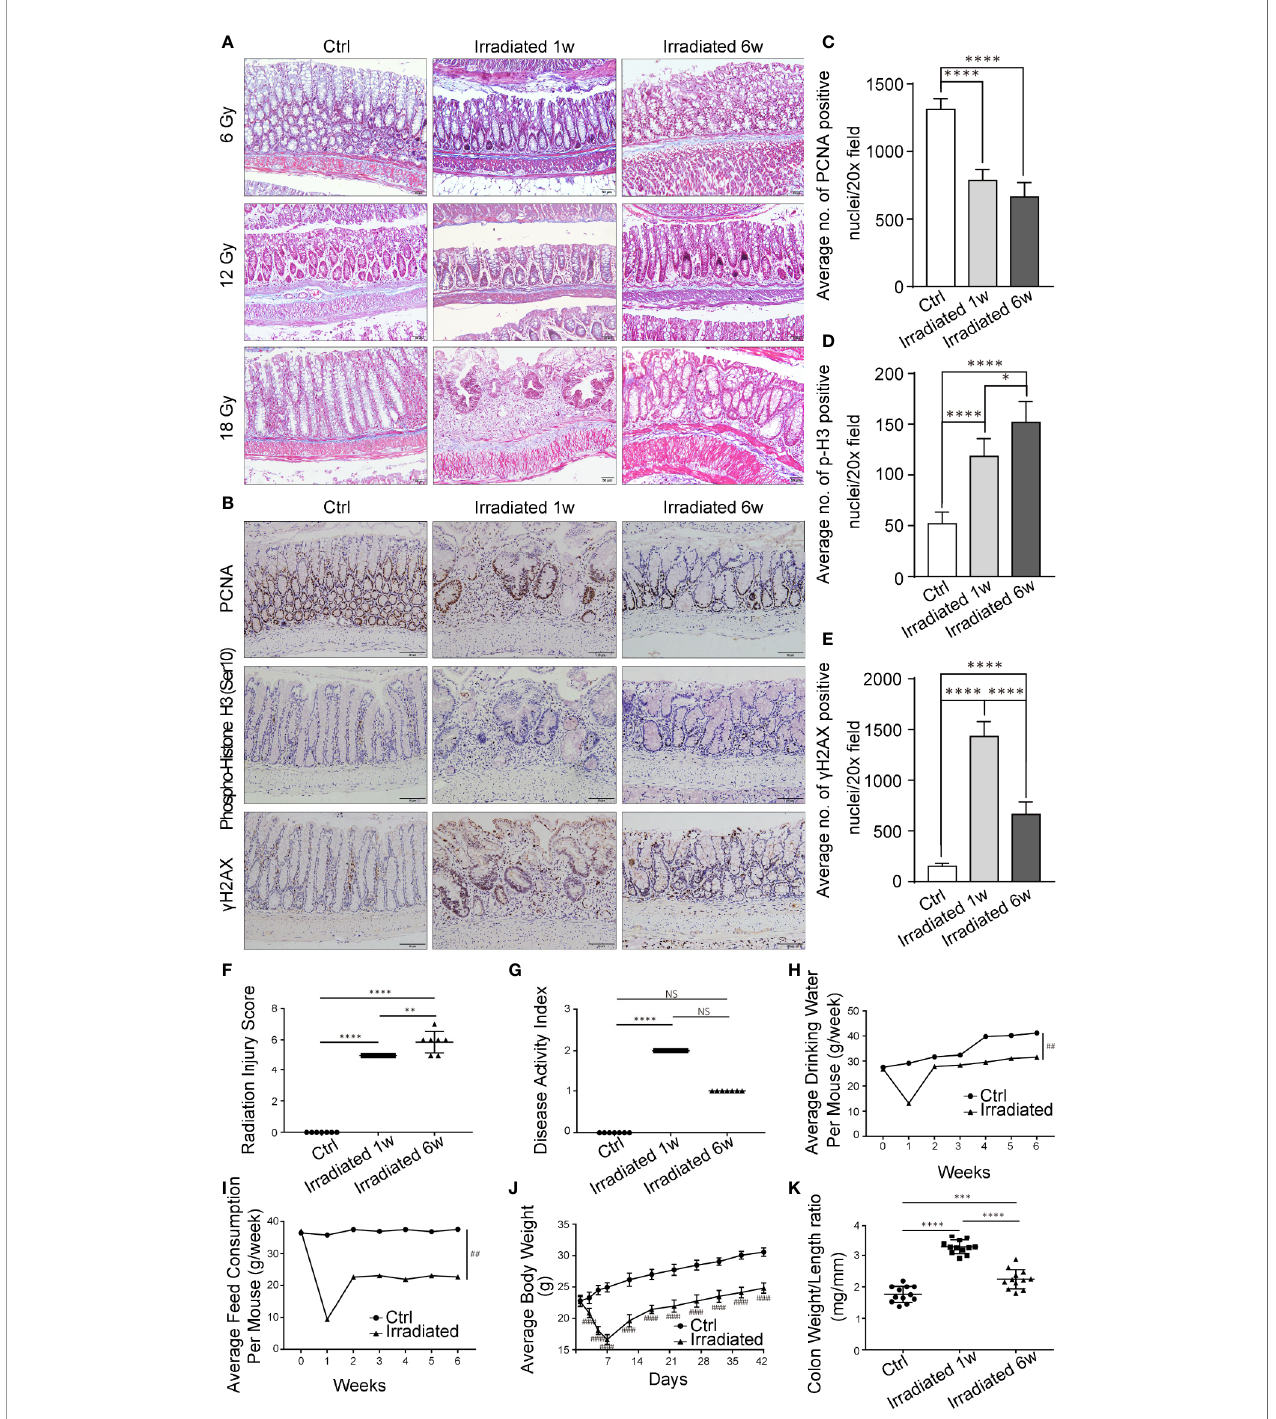
FIGURE 1 | Histopathologic and systemic symptom changes of RE mice. (A) Masson ’ s trichrome stain of colorectum at 1 week and 6 weeks post-irradiation. (B) Immunohistochemical staining of colorectum for PCNA, phospho-histone H3 (Ser10) and g H2AX at 1 week and 6 weeks postirradiation. (C – E) Quanti fi cation of PCNA, phospho-histone H3 (Ser10) and g H2AX positive nuclei in colorectral cells. (F – K) Evaluation of RE severity by using (F) radiation injury score, (G) disease activity index, (H) water consumption, (I) feed consumption, (J) body weight and (K) weight/length ratio of colorectum. Signi fi cance levels are indicated as follows: ****q < 0.0001, ***q < 0.001, **q < 0.01, *q < 0.05; NS q > 0.05; #### p < 0.0001, ## p <